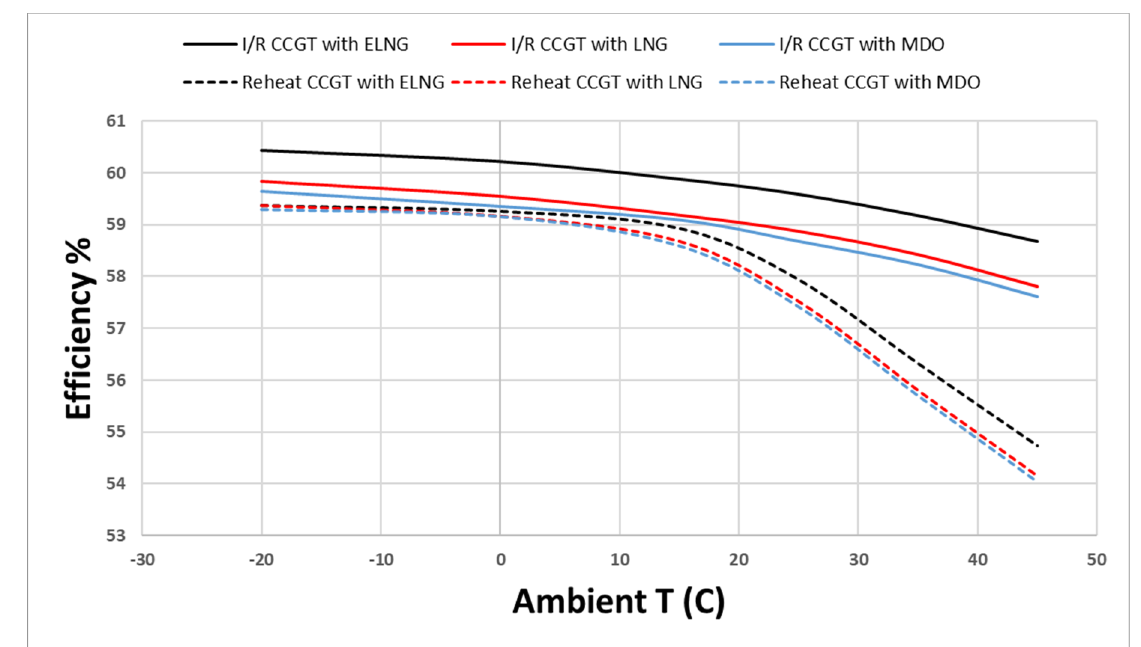
Figure 11. Effects of the ambient temperature on the overall thermal efficiency.